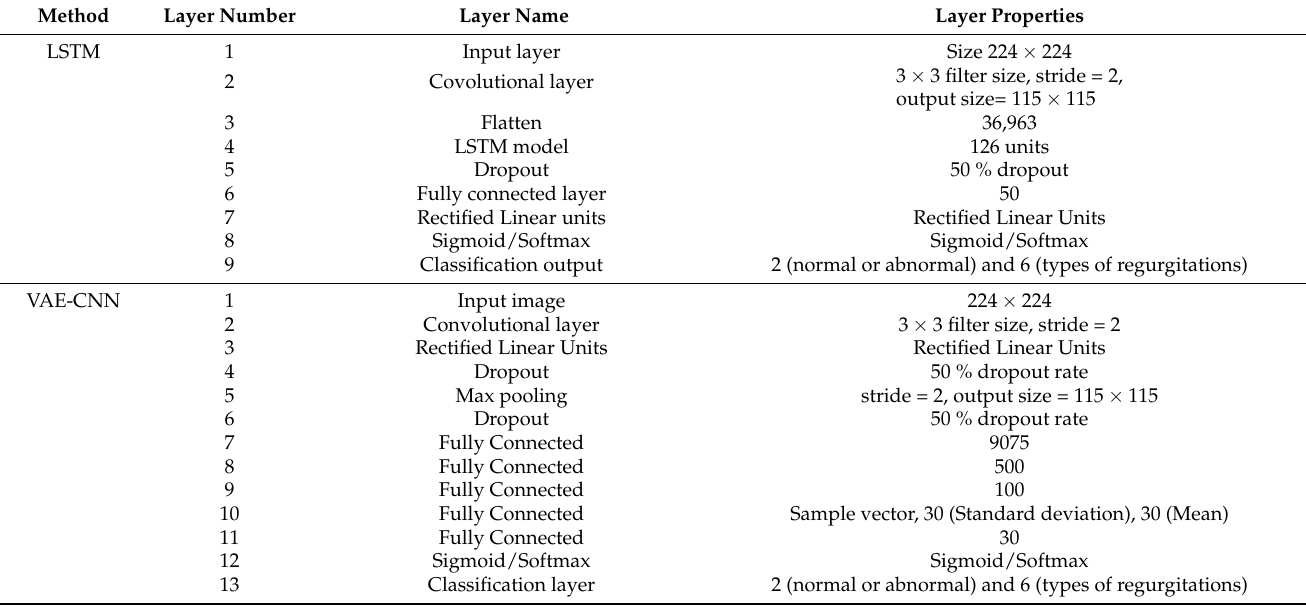
Table 1. Architecture for LSTM and